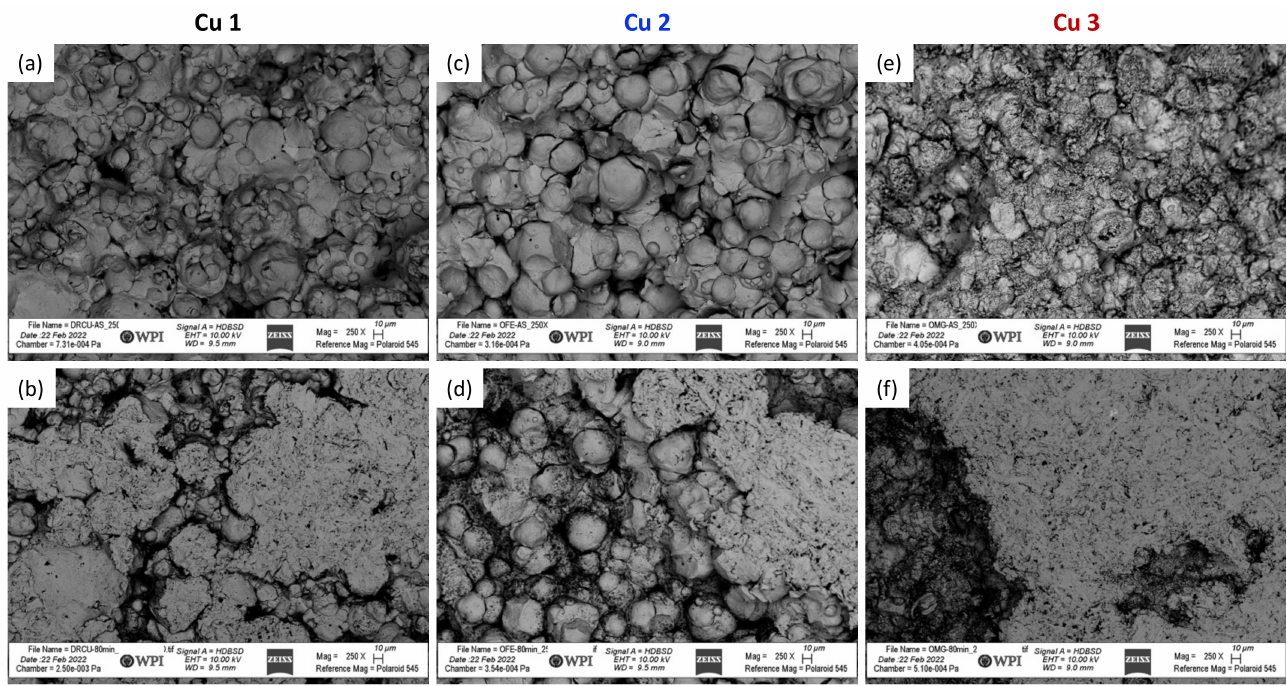
Figure 6. 3D confocal surface topography of the Cu 3 surface as a function of mass finishing time.